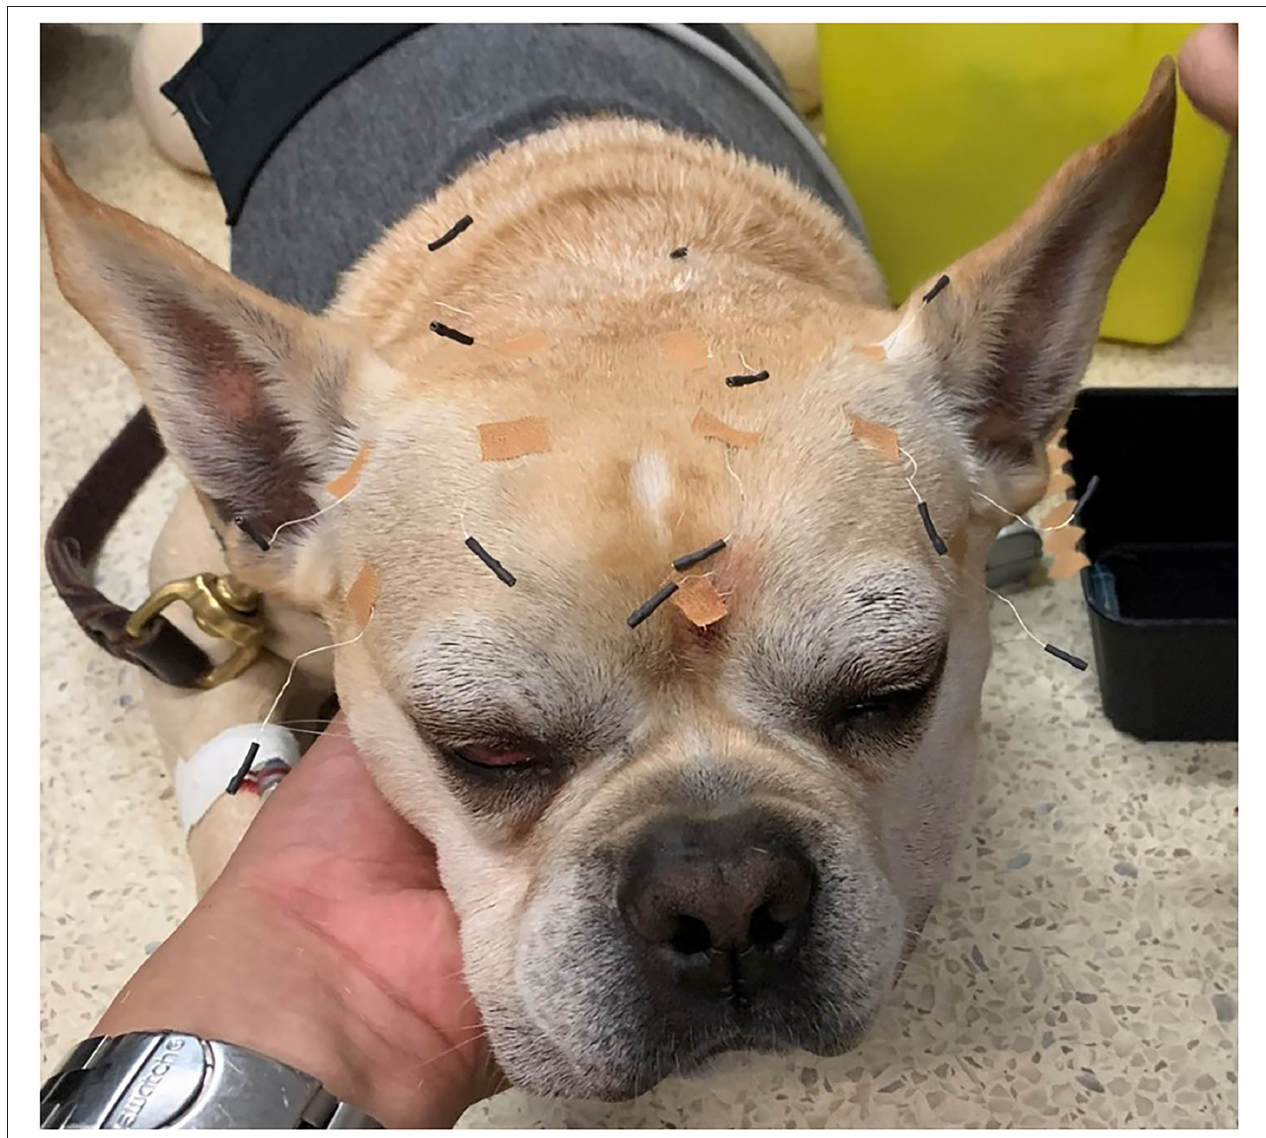
FIGURE 1 | Electrode placing and fixation with sticky tape on a dog sedated with propofol.